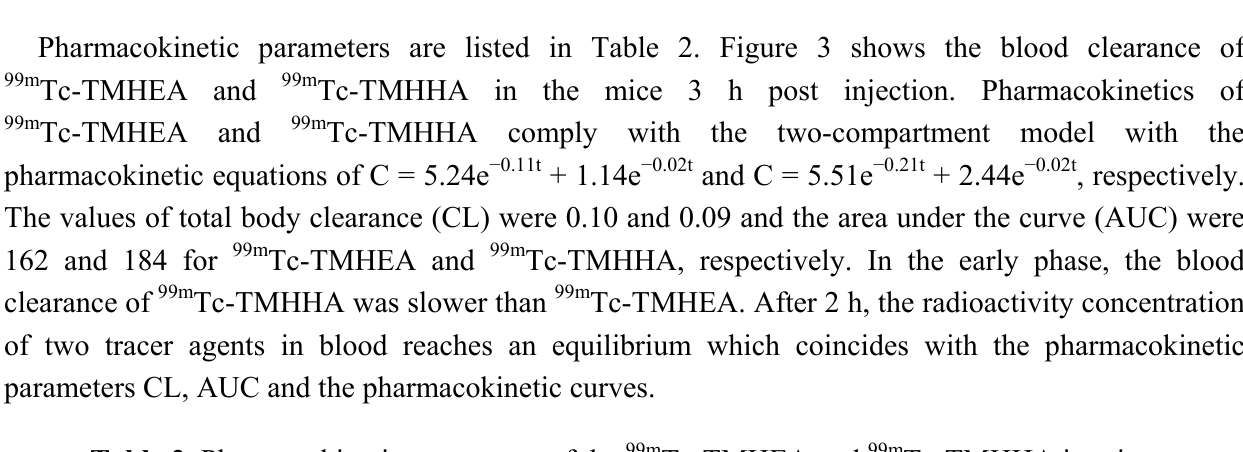
Table 2. Pharmacokinetic parameters of the 99m Tc-TMHEA and 99m Tc-TMHHA in